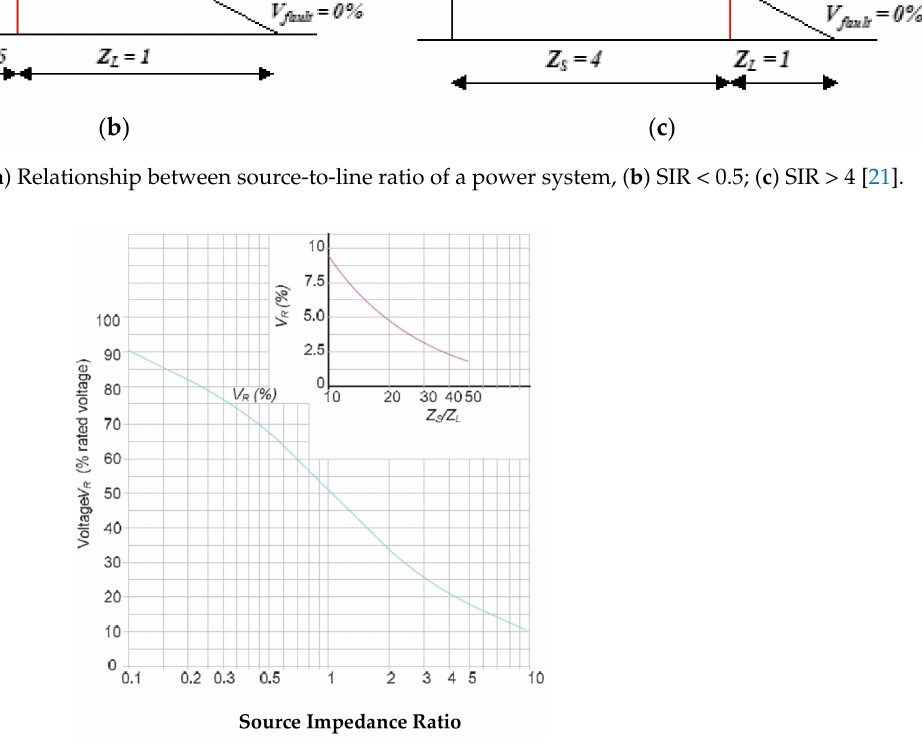
Figure 10. Variation of relay voltage with the system source-to-line impedance ratio